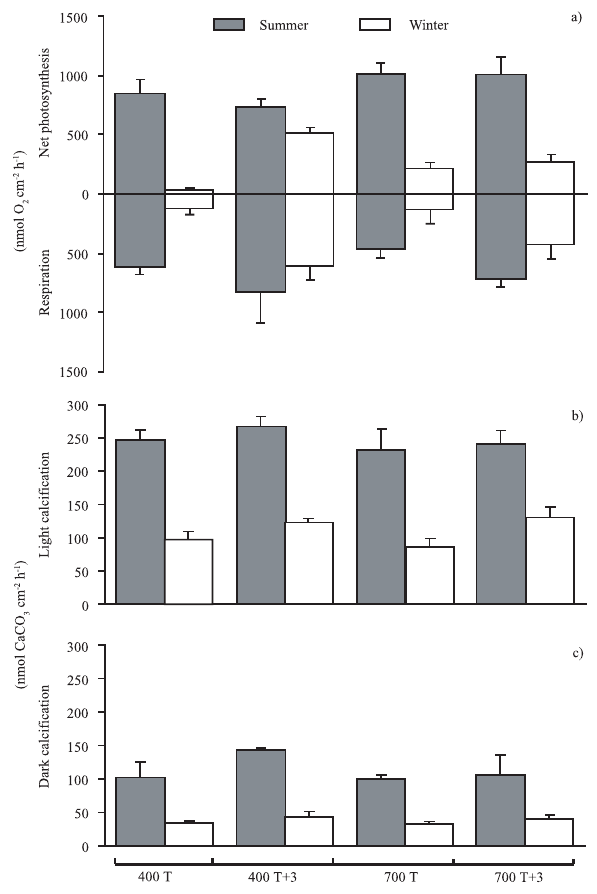
Fig. 2. Net photosynthesis and respiration (a) , and calcification rates measured in the dark and at the culture irradiance level (b) dur- ing the mid-term experiments (summer and winter) on Cladocora caespitosa exposed to the combined effect of normal (400µatm) and elevated (700µatm) p CO 2 , and normal ( T ) and elevated ( T +3 ◦ C) temperatures. Data are mean ± s.e.m. (see Table 2 for degrees of